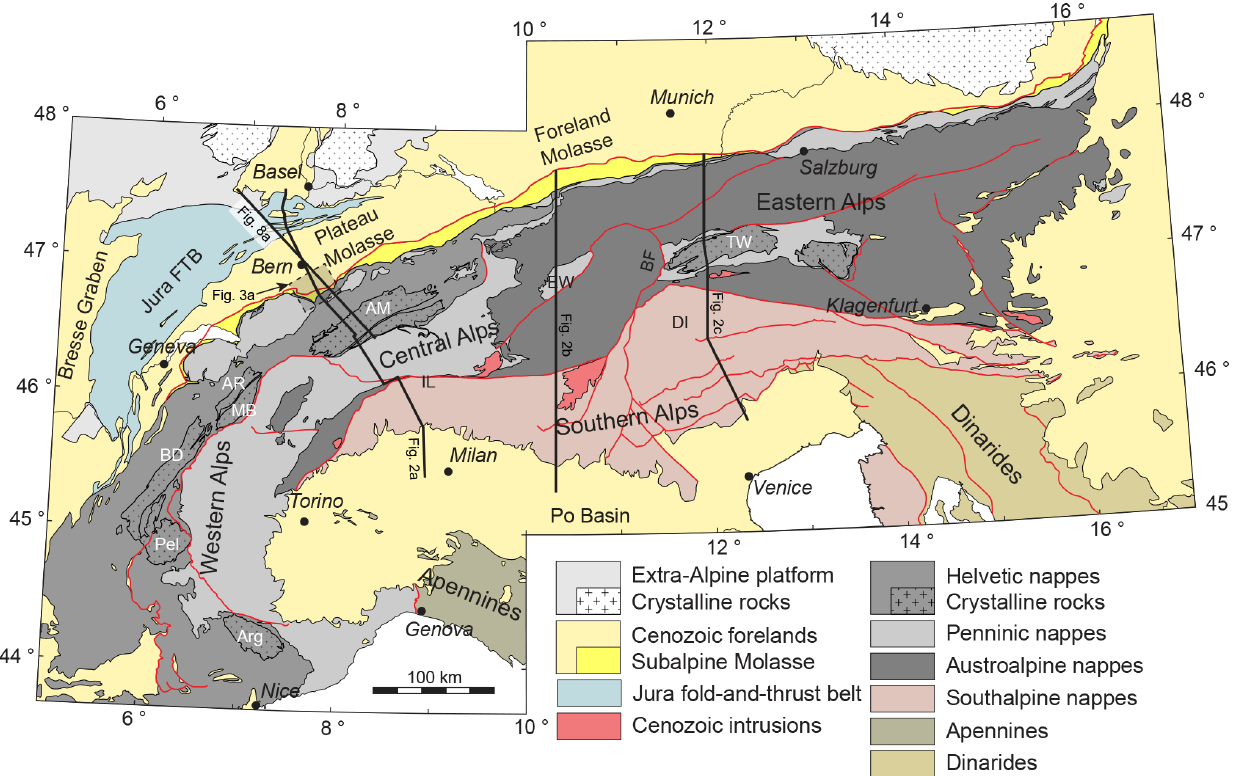
Figure 1. Tectonic map of the European Alps and its foreland basins (adapted from Schmid et al., 2004). Traces of the cross sections in Figs. 2 and 8a are given as bold black lines. The sample area south of Bern (Fig. 3a) is denoted by a dashed rectangle. AM, Aar Massif; AR, Aiguilles Rouges Massif; BD, Belledonne Massif; BF, Brenner Fault; DI, Dolomite indenter; EW, Engadine Window; FTB, fold-and-thrust belt; IL, Insubric Line; MB, Mont Blanc Massif; Pel, Pelvoux Massif; TW, Tauern